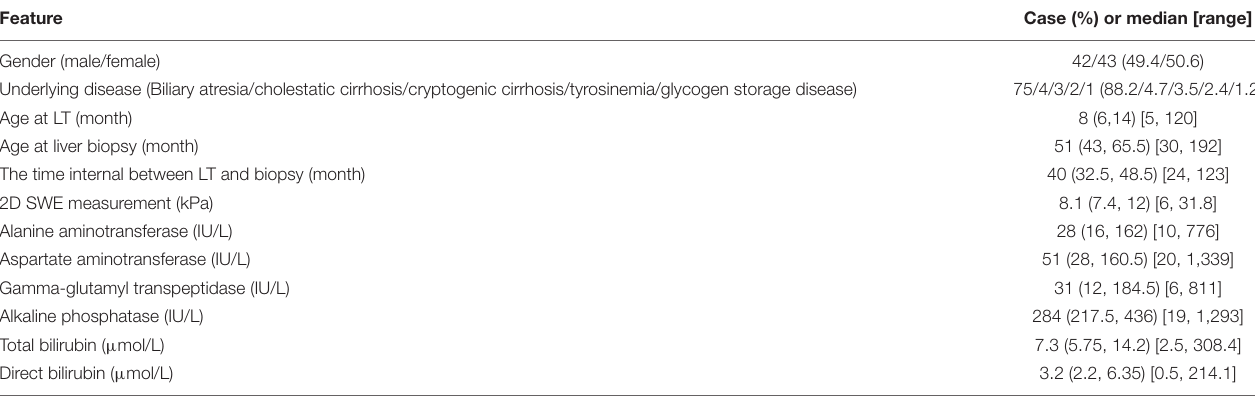
TABLE 1 | Baseline characteristics of the pediatric recipients. Feature